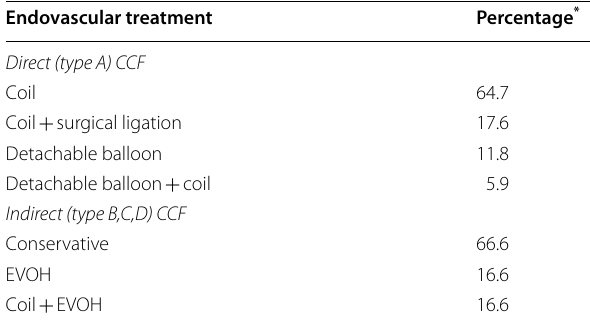
Table 3 Treatment modalities in direct and indirect fistula